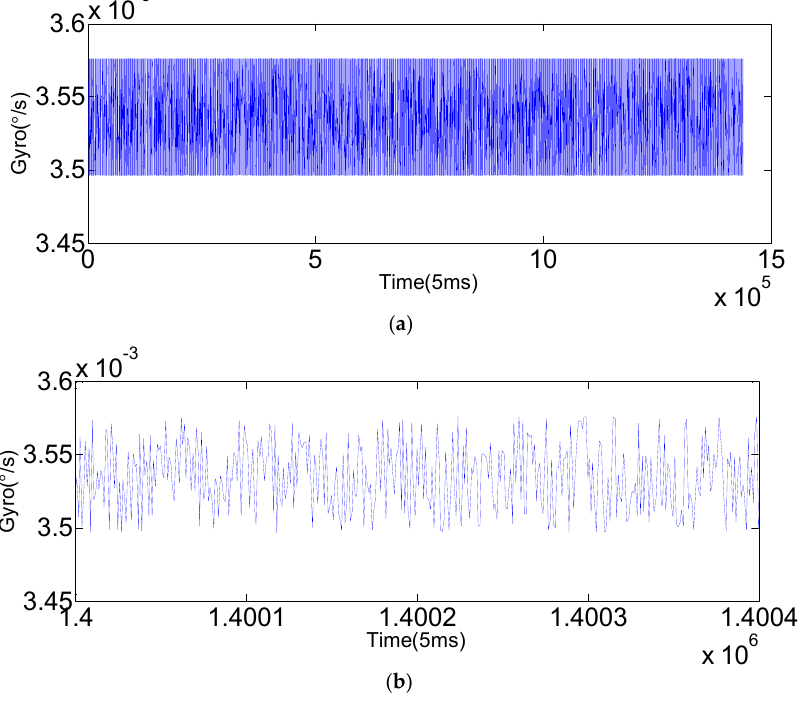
Figure 9. The filtering result of the modified SHAKF. ( a ) The filtering result of a single axis ( x -axis) FOG for 2 h; ( b ) local enlarged graphs.